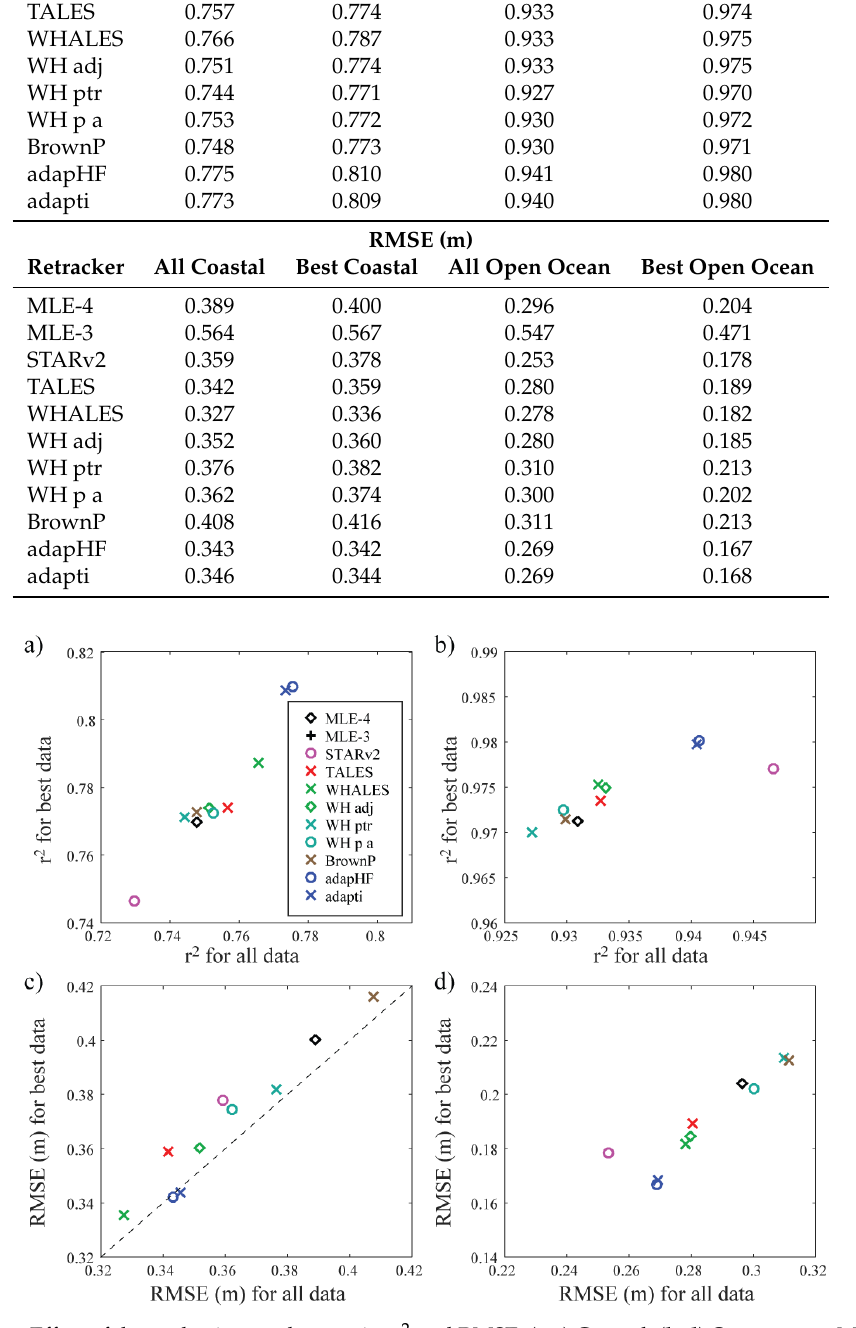
Figure 13. Effect of data selection on the metrics r 2 and RMSE. ( a , c ) Coastal; ( b , d ) Open ocean. MLE-4 is the default algorithm for Jason-3, and MLE-3 retrievals are much worse than the others (lower r 2 and higher RMSE), so they are not in the domains focussed on in each panel. Note those algorithms indicated by a circle have some implicit along-track smoothing in